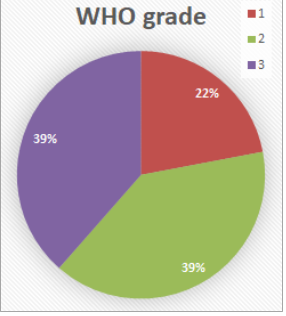
Figure 4. WHO grade distribution.